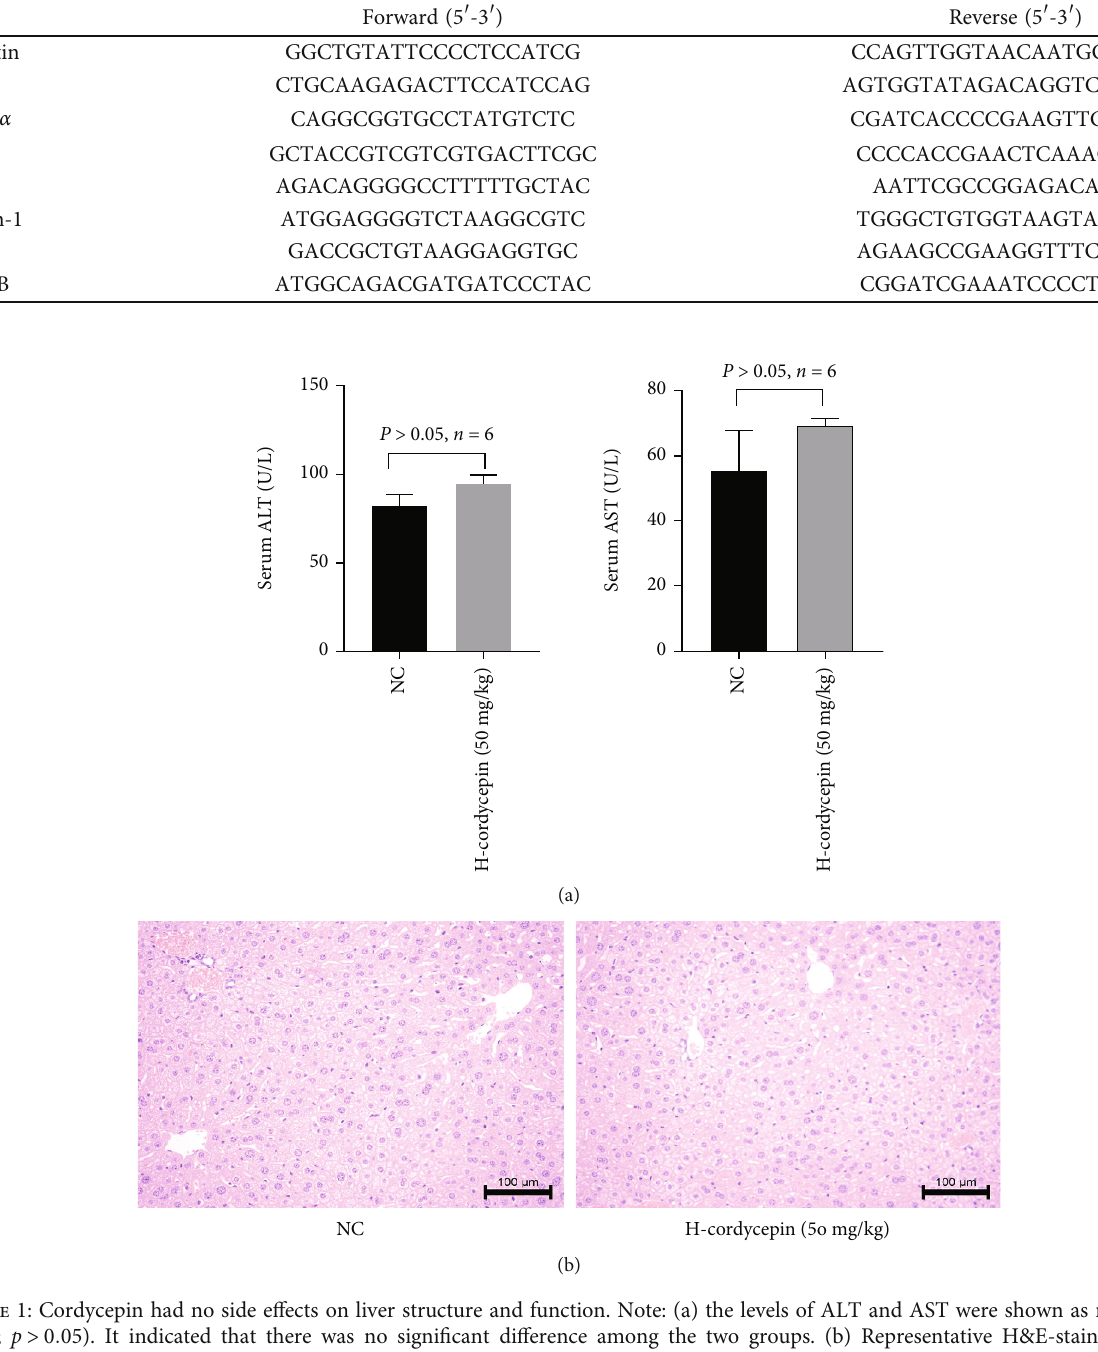
Table 1: Oligonucleotide sequences of primers used for qRT-PCR.